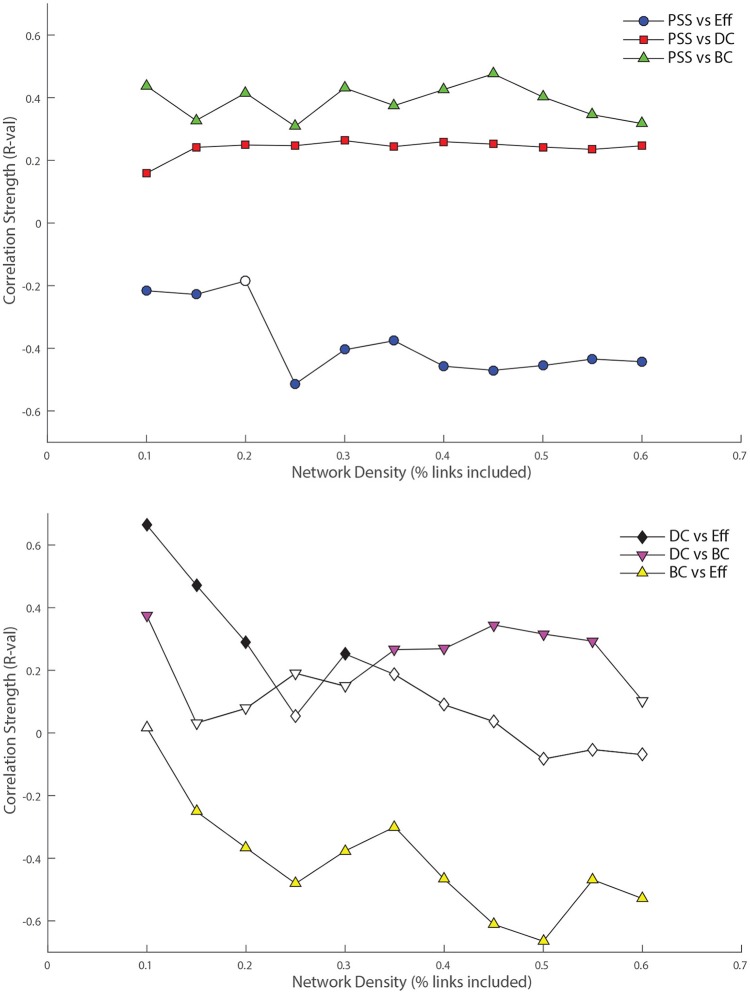
Top: Relationship between nodal persistence scaffold strength (PSS) and standard topological centrality measures. At each threshold under study, the value of the bivariate correlation coefficient (R) between PSS and each of: degree-centrality (DC), betweenness-centrality (BC), and local efficiency (Eff) is plotted. Bottom: Relationship between standard topological measures. The same procedure as above is repeated for correlations between: DC vs. BC, DC vs. Eff, and BC vs. Eff as control conditions. Filled shapes indicate the presence of a statistically significant correlation between the two variables (p < 0.05).